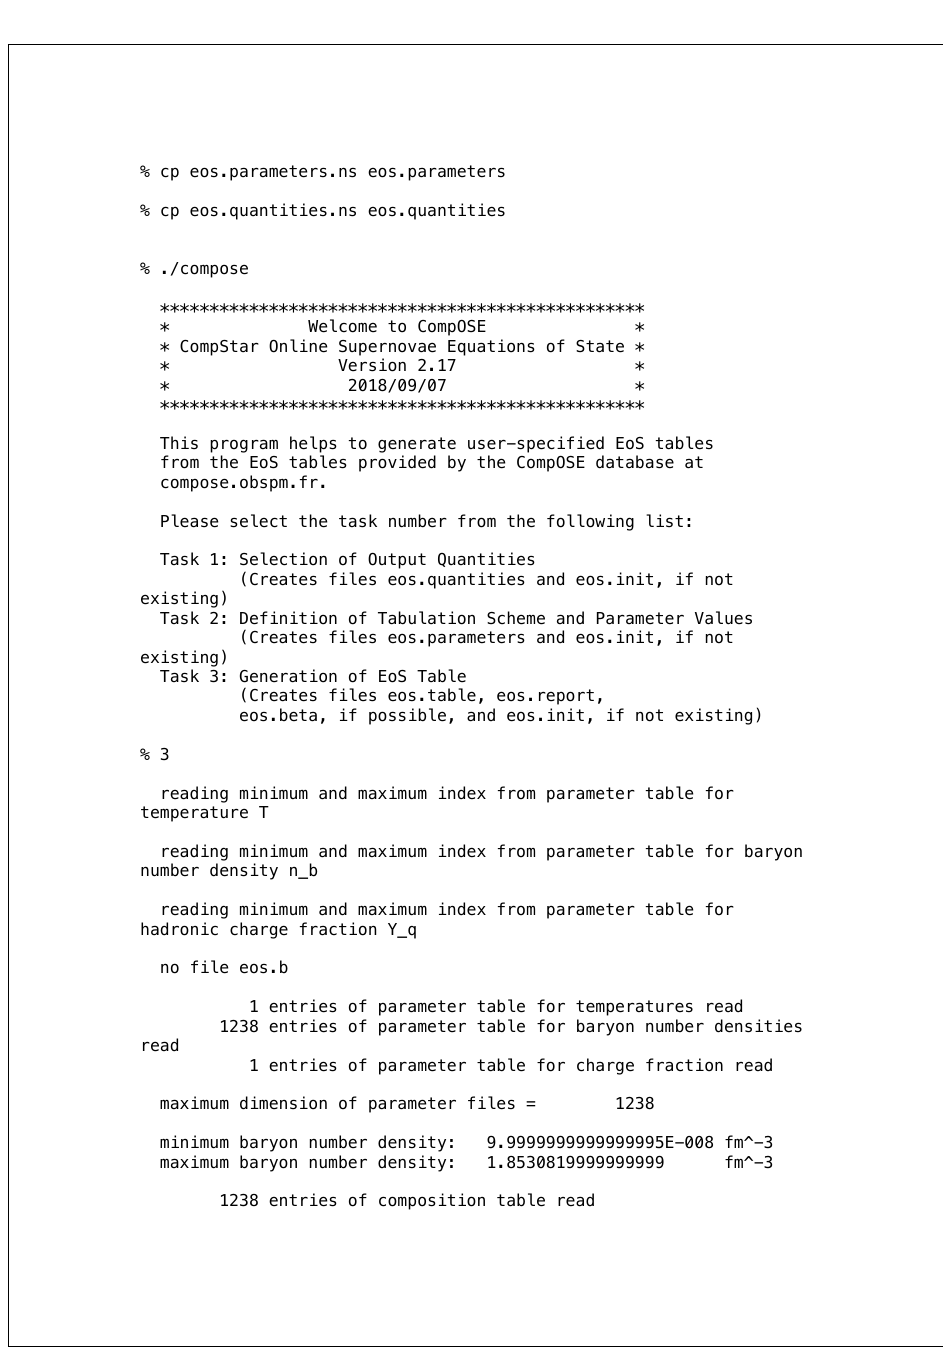
Figure A4. Snapshot when running compose for computing sound speed and adiabatic index from a cold neutron star